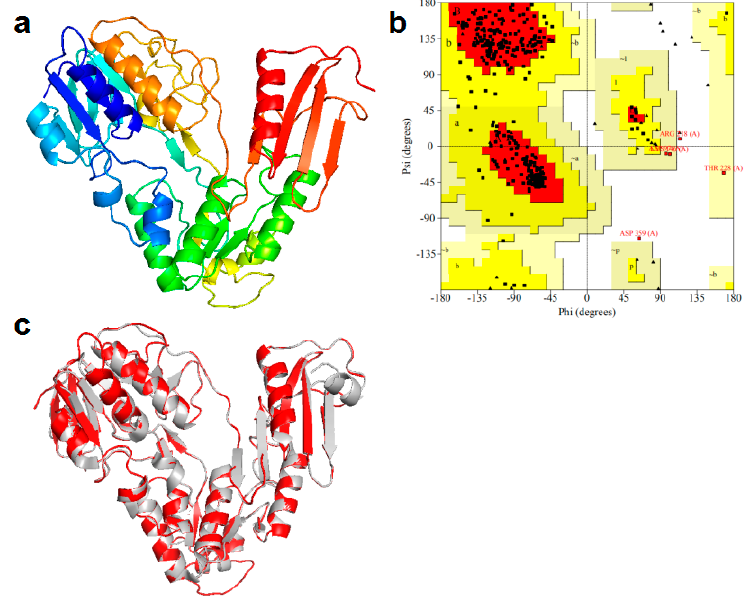
Figure 5. Homology modeling (NH 2 -terminal domain) of NiR-A2: ( a ) the modeled 3D-structure, blue represents the N-terminus, and red represents the C-terminus; ( b ) the Ramachandran plot of the homology-modeled structure; ( c ) the overlap between the NADH: rubredoxin oxidoreductase (represented in grey) and the NH 2 -terminal amino acid sequence of